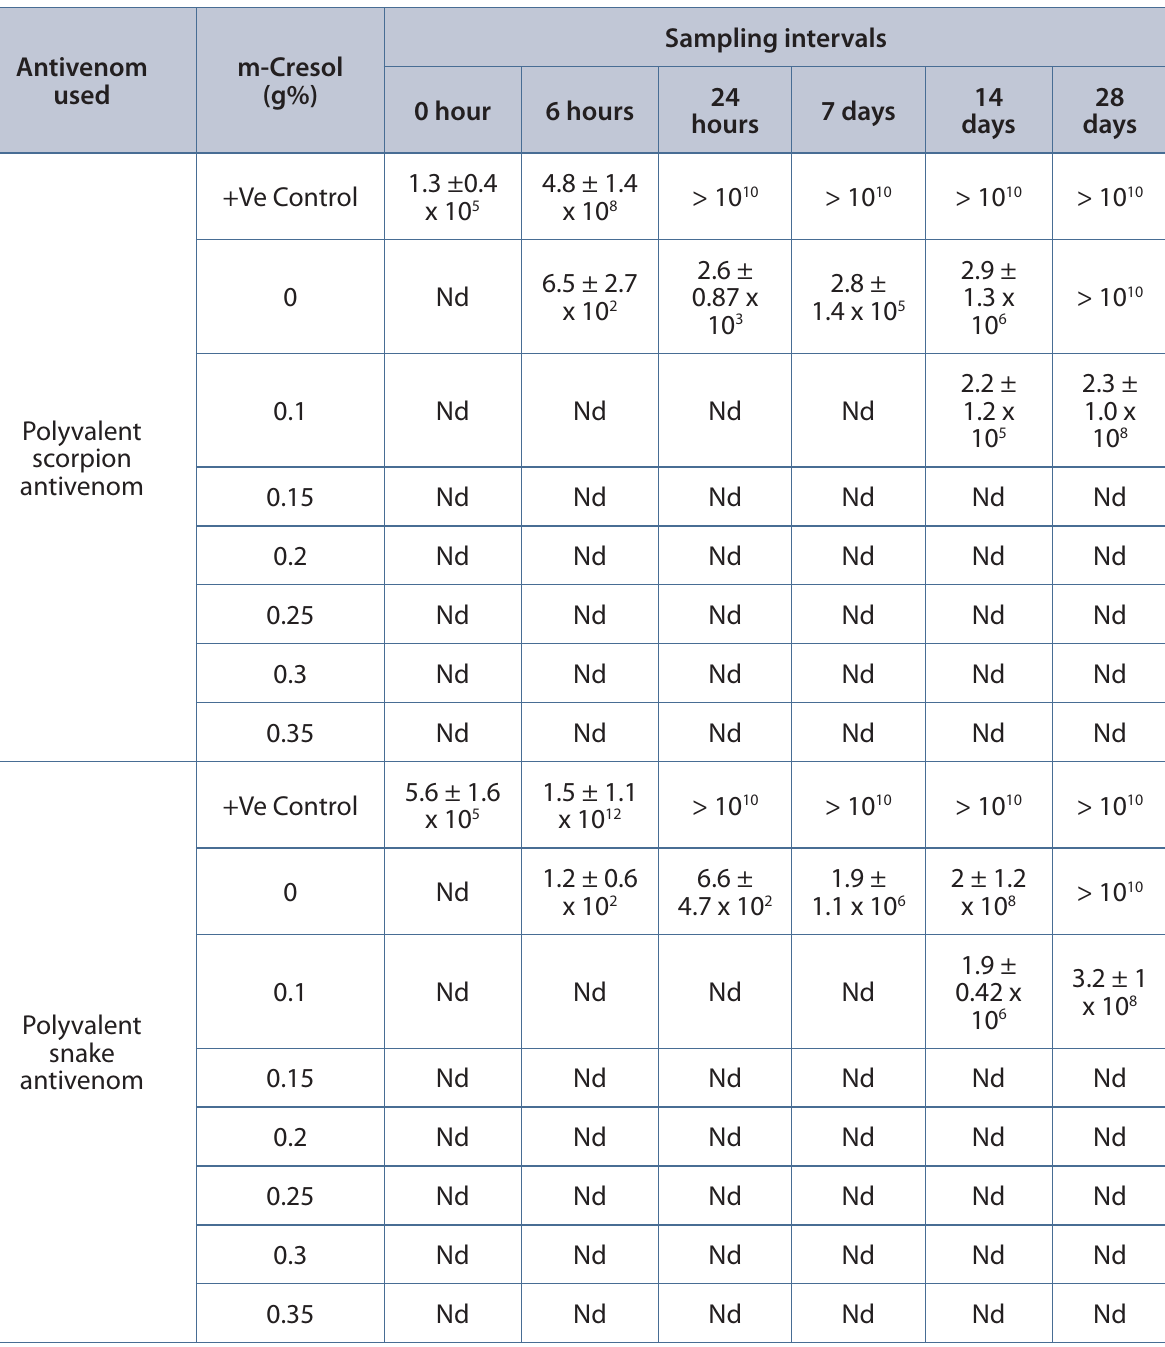
Values represent the mean of six samples followed by their respective standard error of the mean. CFU: colony-forming unit; Nd: not